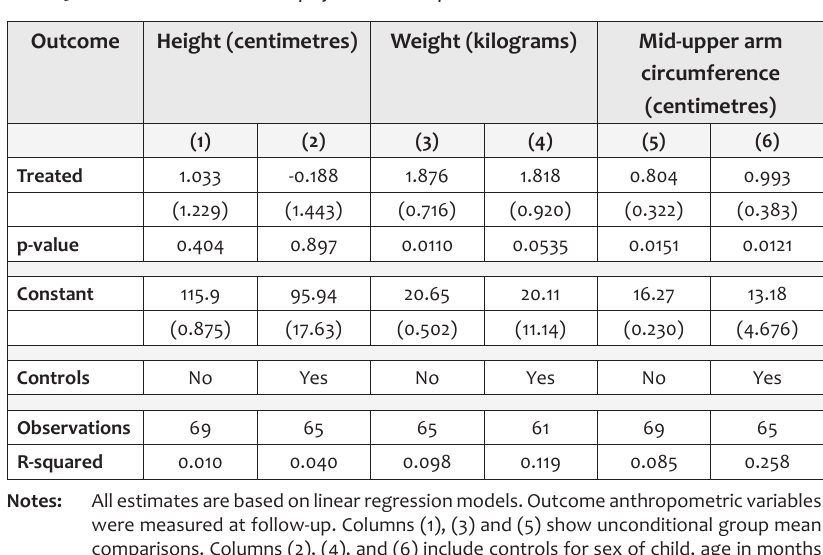
Table 5: Center attendance and physical